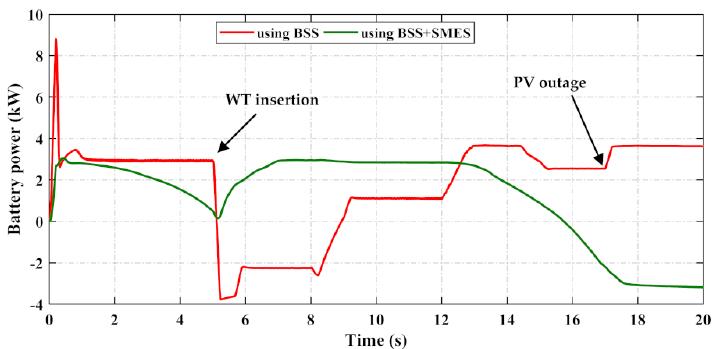
Figure 15. The battery power using battery only and using BSS +